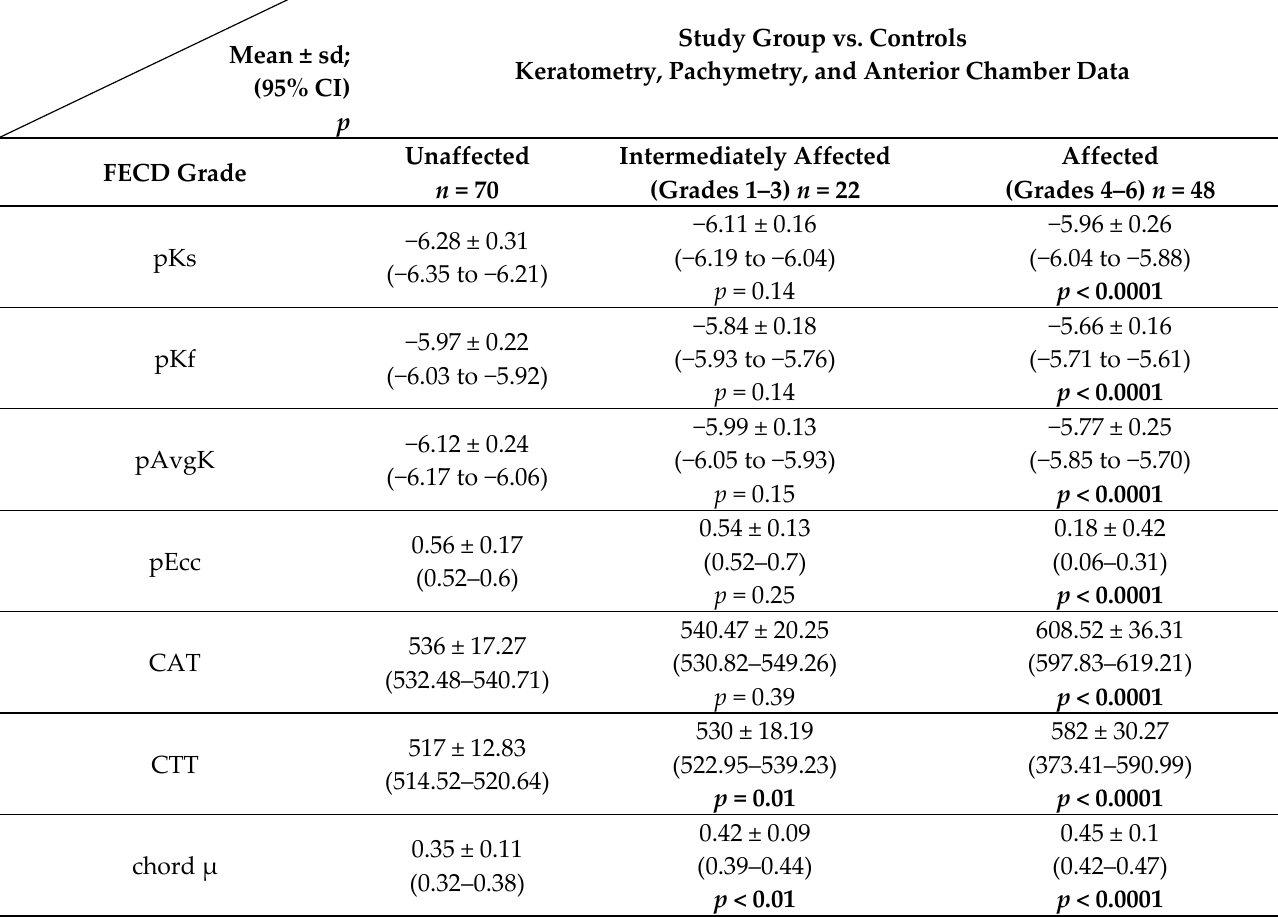
Table 3. Comparison of keratometry data of the intermediately affected, affected, and unaffected eyes.